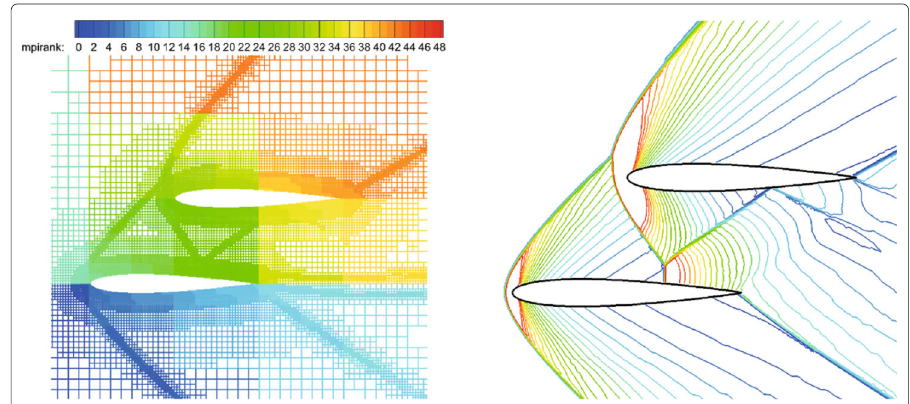
Fig. 15 Supersonic flow around two staggered NACA0012 airfoils. Left: the partition of adaptive grids on 48 cores. Right: pressure contour